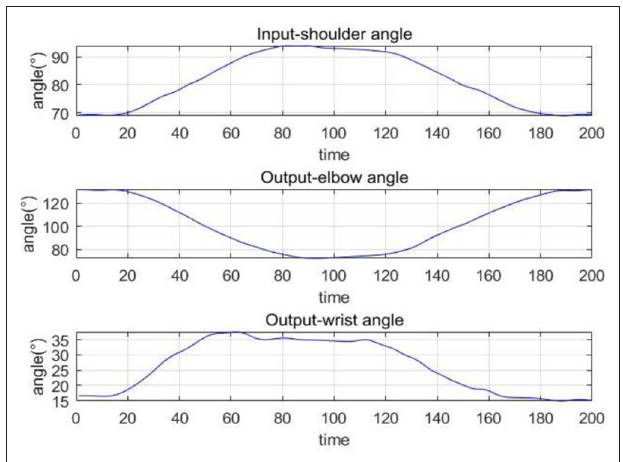
FIGURE 11 | An example of the coordination relationship trained from the CNN-LSTM model (Task